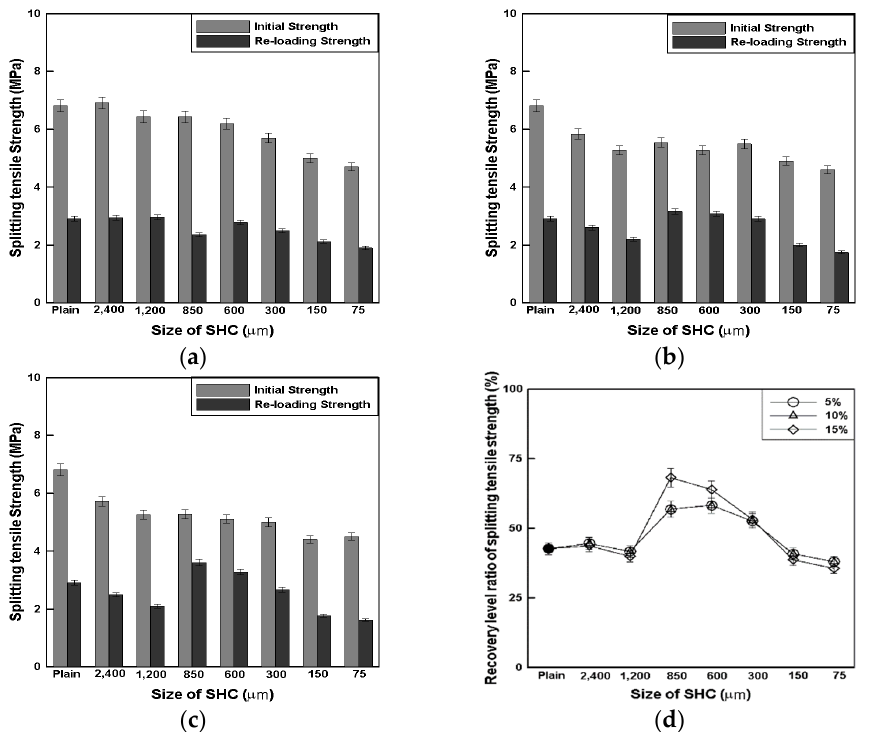
Figure 10. Re-loading test result of splitting tensile strength: ( a ) SHC 5%, ( b ) SHC 10%, ( c ) SHC 15%, ( d ) recovery level. ( d ) recovery level.